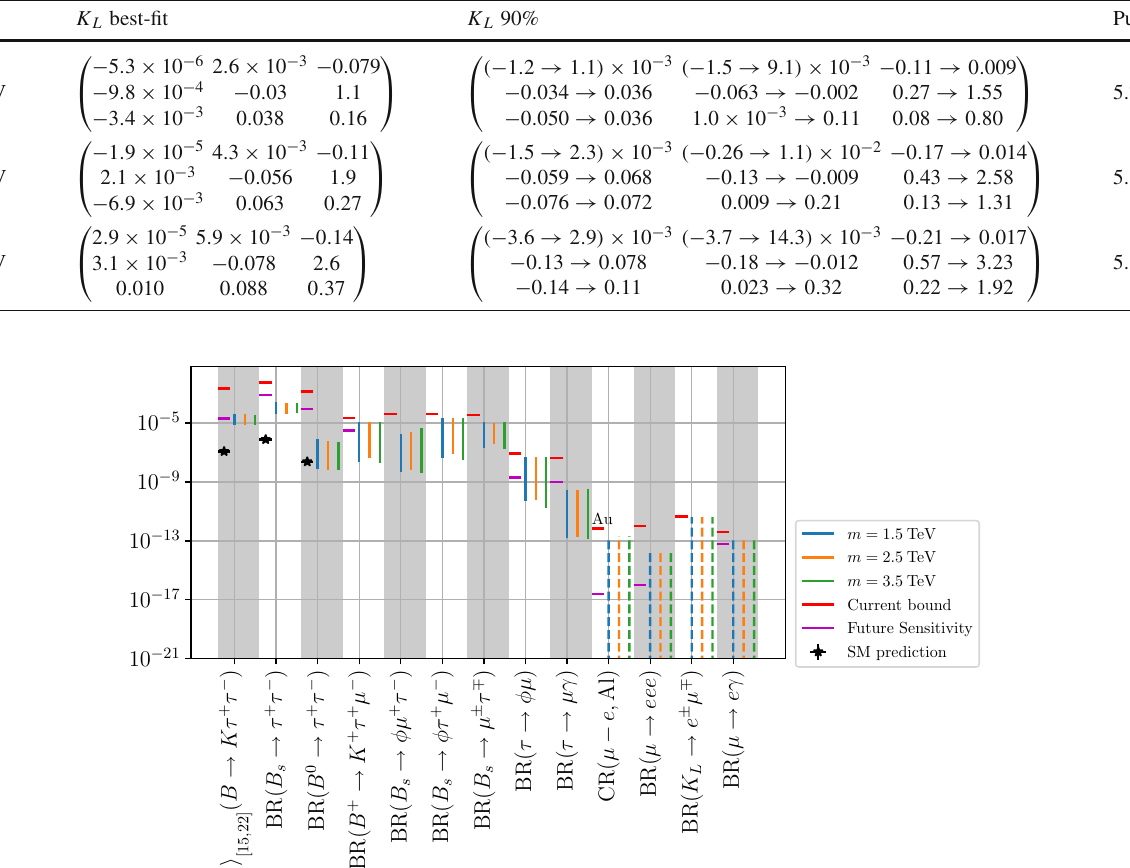
. The SM pull is reduced from ∼ 6 . 4 σ to ∼ 5 . 8 σ L